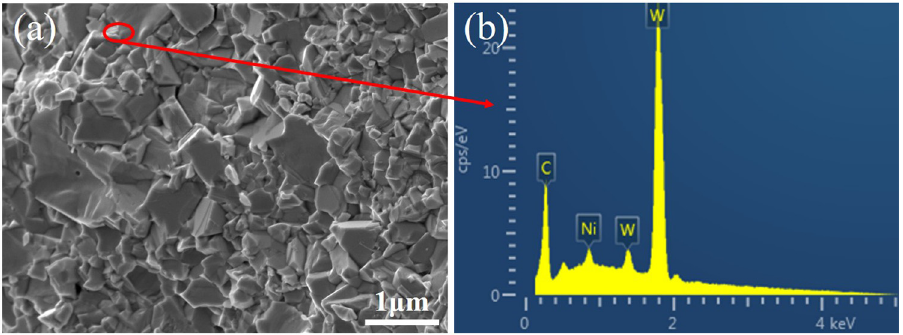
Figure 10: WCN - 6# specimen fracture scanning and EDS results, ( a ) specimen fracture scanning, and ( b ) EDS